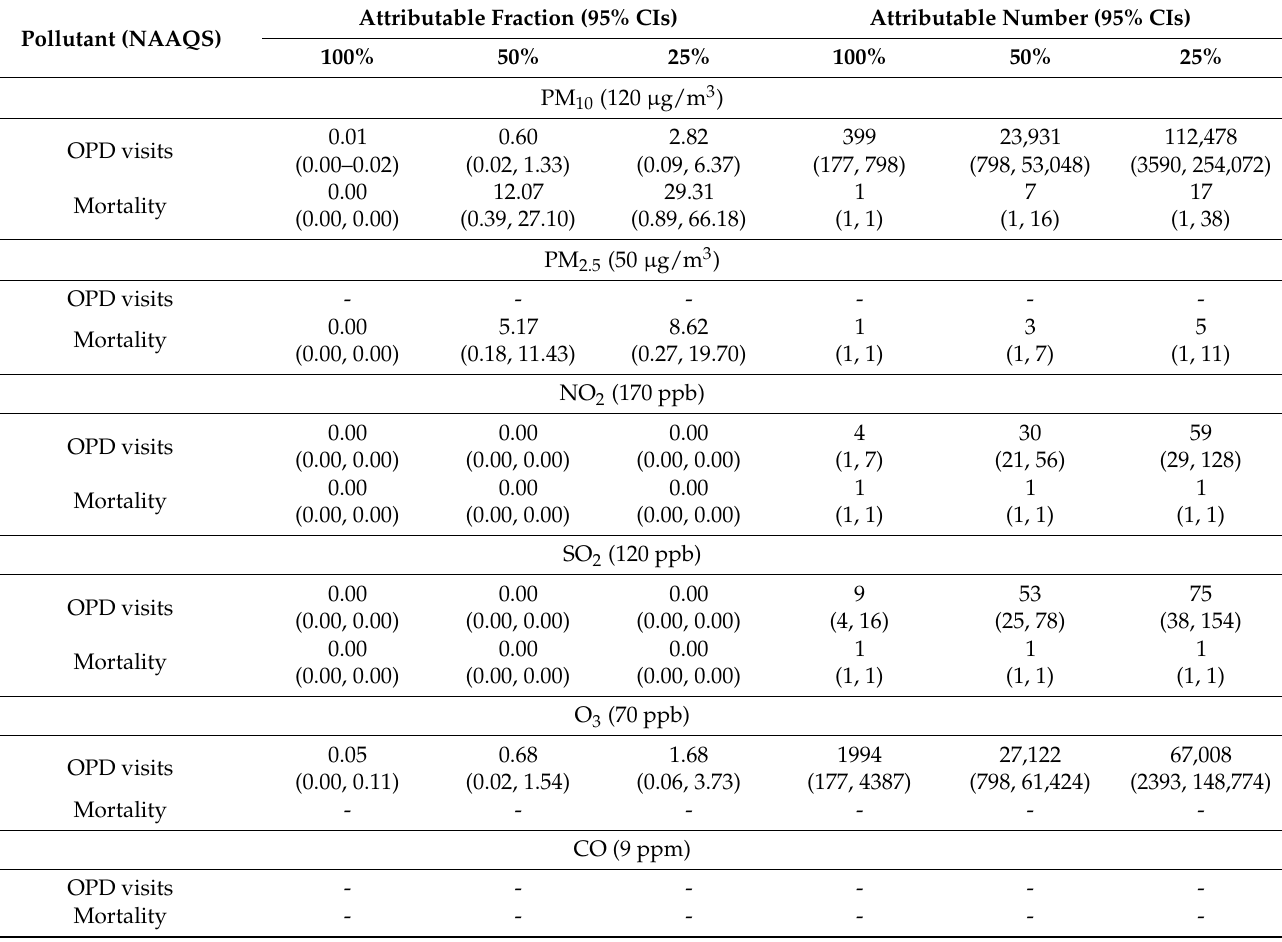
Table 9. Attributable fractions and attributable numbers of outpatient department (OPD) visits and mortalities for acute upper respiratory infections caused by air pollutant concentrations in the Eastern Economic Corridor of Thailand exceeded the national ambient air quality standard (NAAQS) (100%),